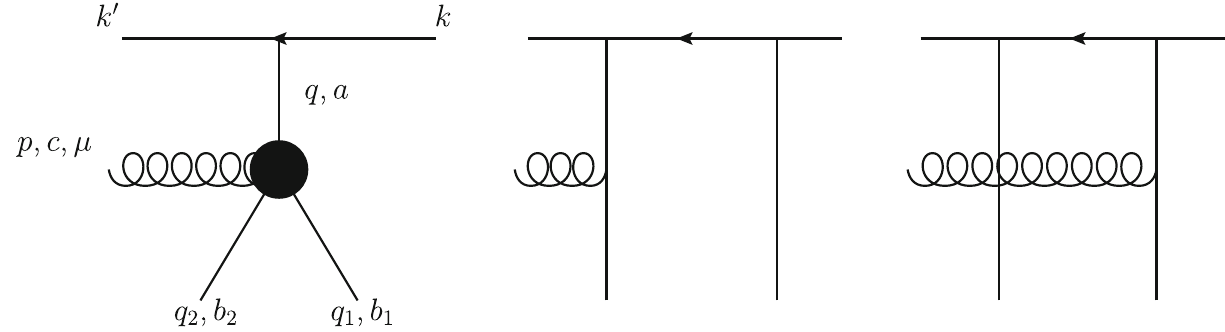
Fig. 1 Production amplitude: vertex and rescattering contributions